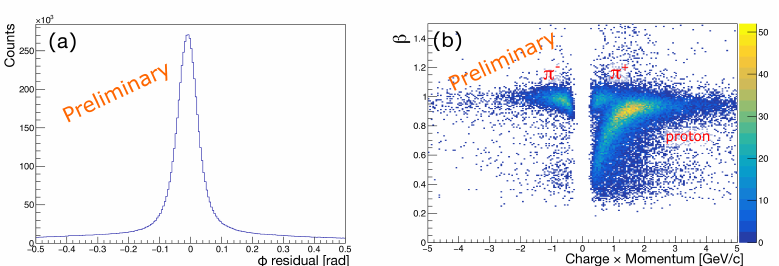
Figure 4. Analysis of the WASA detectors. (a) Di ff erence of the ϕ angle between MDC hit wire and track obtained by MFT. (b) Correlation between β and